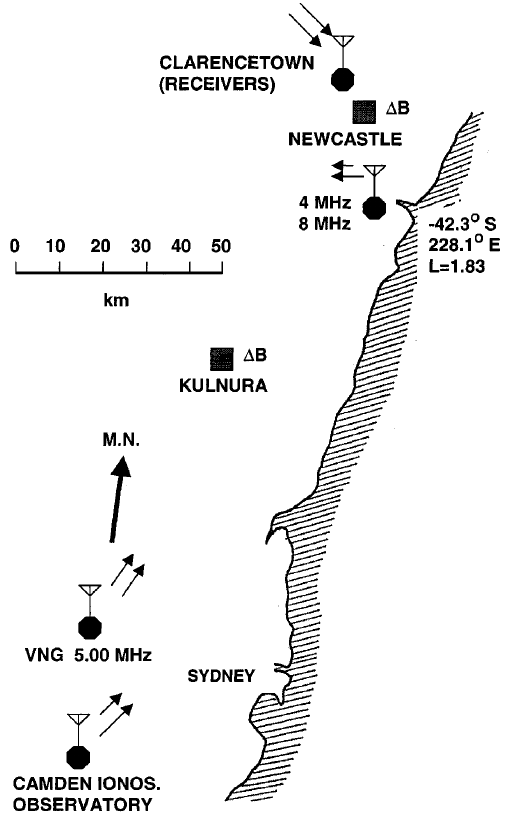
Fig. 1. Map showing locations of 4 and 8 MHz transmitters ( Newcastle ), ground magnetometer ( Newcastle D B ), 5.00 MHz HF Doppler transmitter ( VNG ) and Doppler receivers ( Clarencetown ). The direction of geomagnetic north is represented by M . N . The magnetometer at Kulnura was used for cross-phase determinations of the field line resonance frequency during the